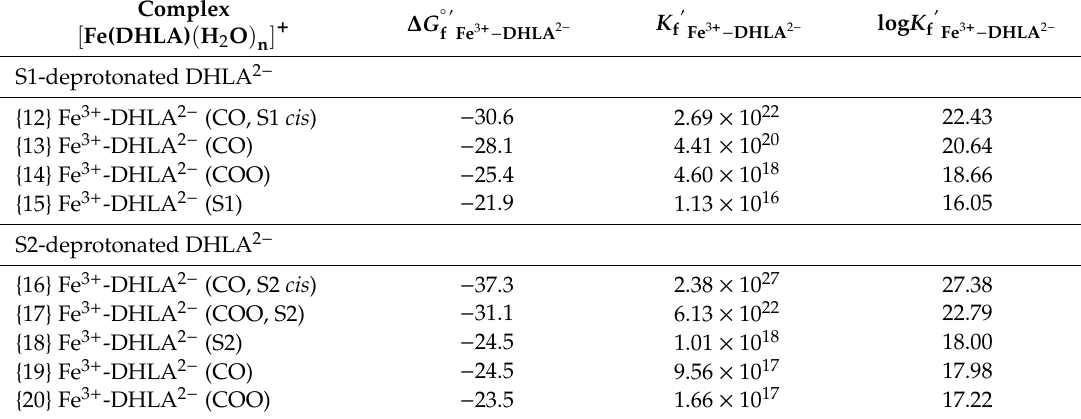
Table 3. Standard Gibbs free energy change ( ∆ G for the chelation of Fe(III) with S1- and S2-deprotonated DHLA 2 − from DHLA – and the hydrated central ion (as per Equation (7)) in aqueous solution at 298.15 K.